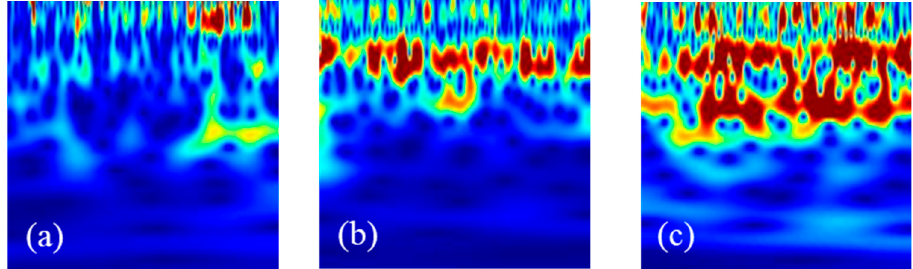
Figure 13. Typical CWT segmented scalograms for ( a ) good surface quality, ( b ) marginal surface quality with minor cracks, and ( c ) poor surface quality.